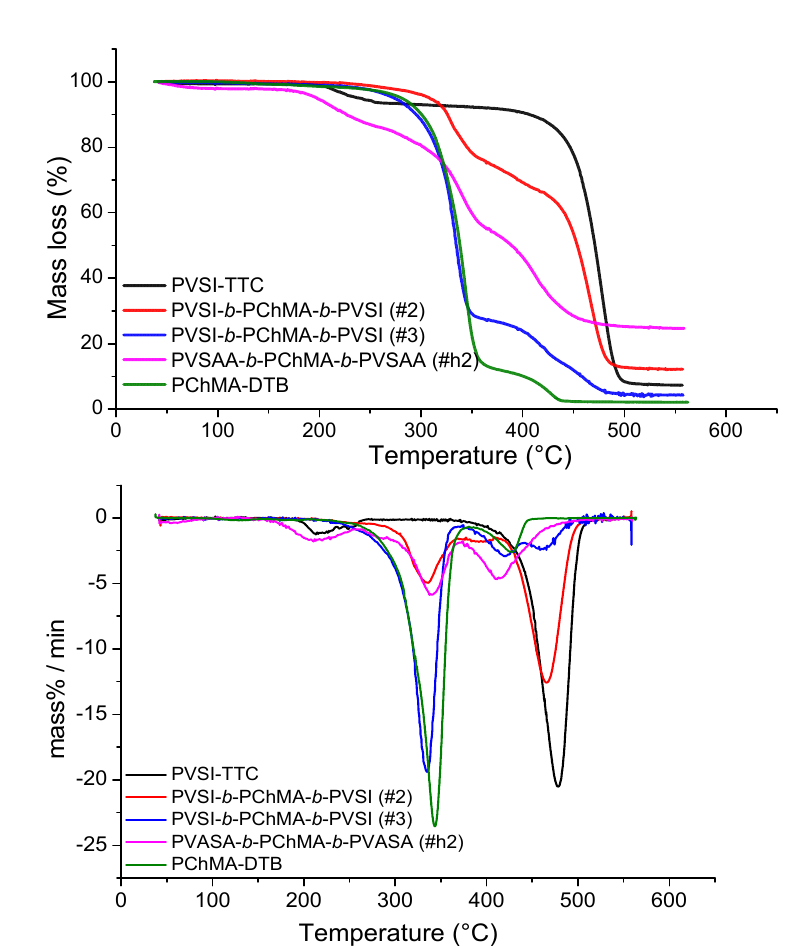
Figure 7. TGA ( A ) and DTG ( B ) plots for PVSI/PVSAA-containing copolymers with PChMA and corresponding homopolymers.